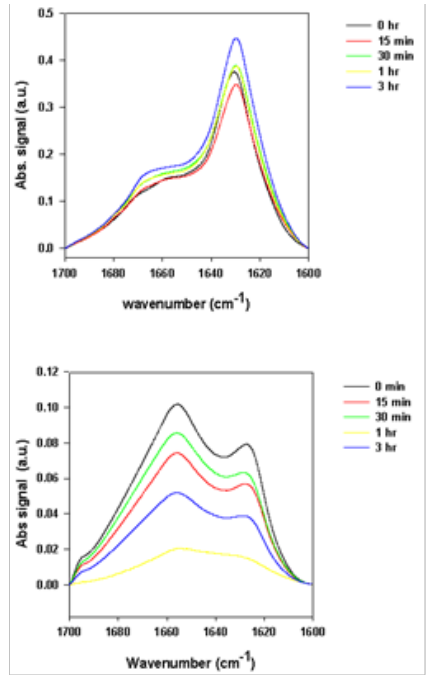
Figure 5. Superimposed ATR-FTIR spectra of precipitate samples (top panels) and supernatant samples (bottom panels) taken at the end of the fibrillation